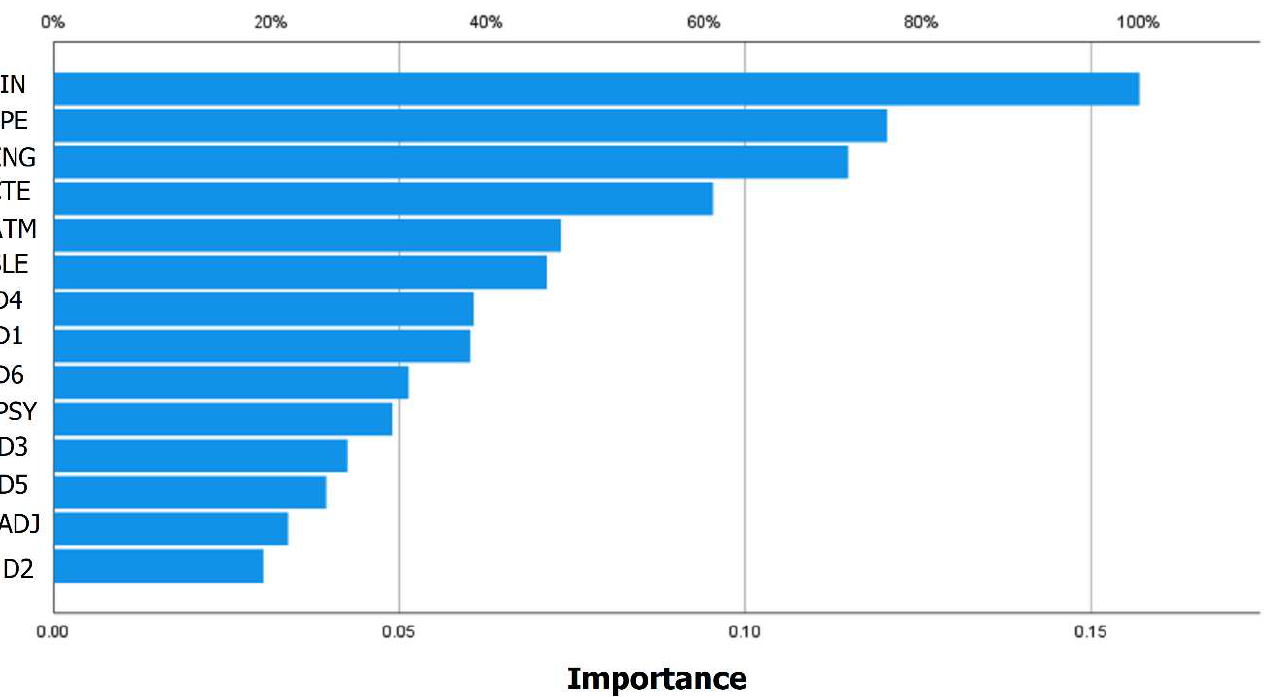
Figure A1. Normalized importance by the artificial neural network (ANN2) model.